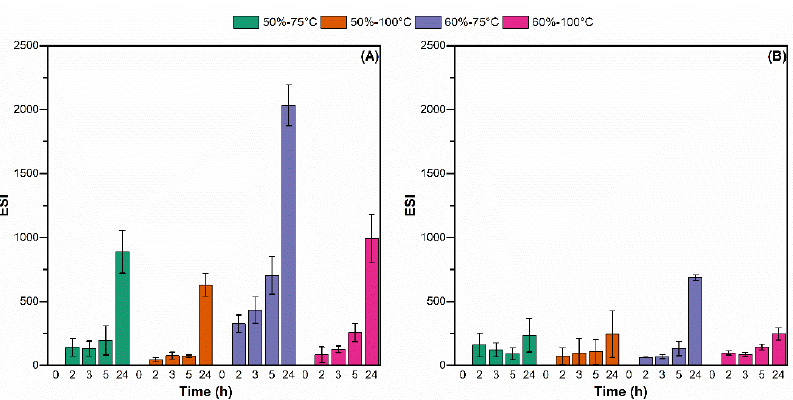
Figure 9. Emulsion stability index (ESI) at the lower (( A ), height = 2 – 3 cm) and higher (( B ), height = 10 – 12 cm) of the reconstituted 50%-75 °C (green), 50%-100 °C (orange), 60%-75 °C (purple), and 60%-100 °C (pink) IMF emulsions, after 0, 2, 3, 5, and 24 h.